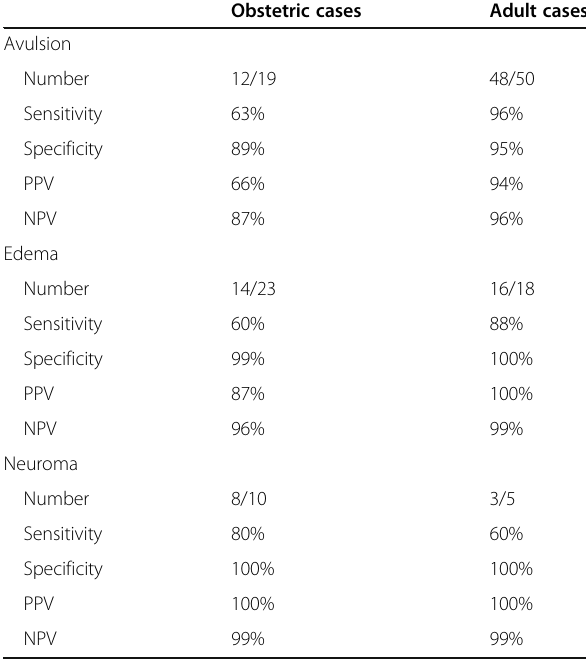
Table 2 Comparison of MRI diagnostic performance in obstetric and adult traumatic brachial plexus injury as compared to operative findings Obstetric